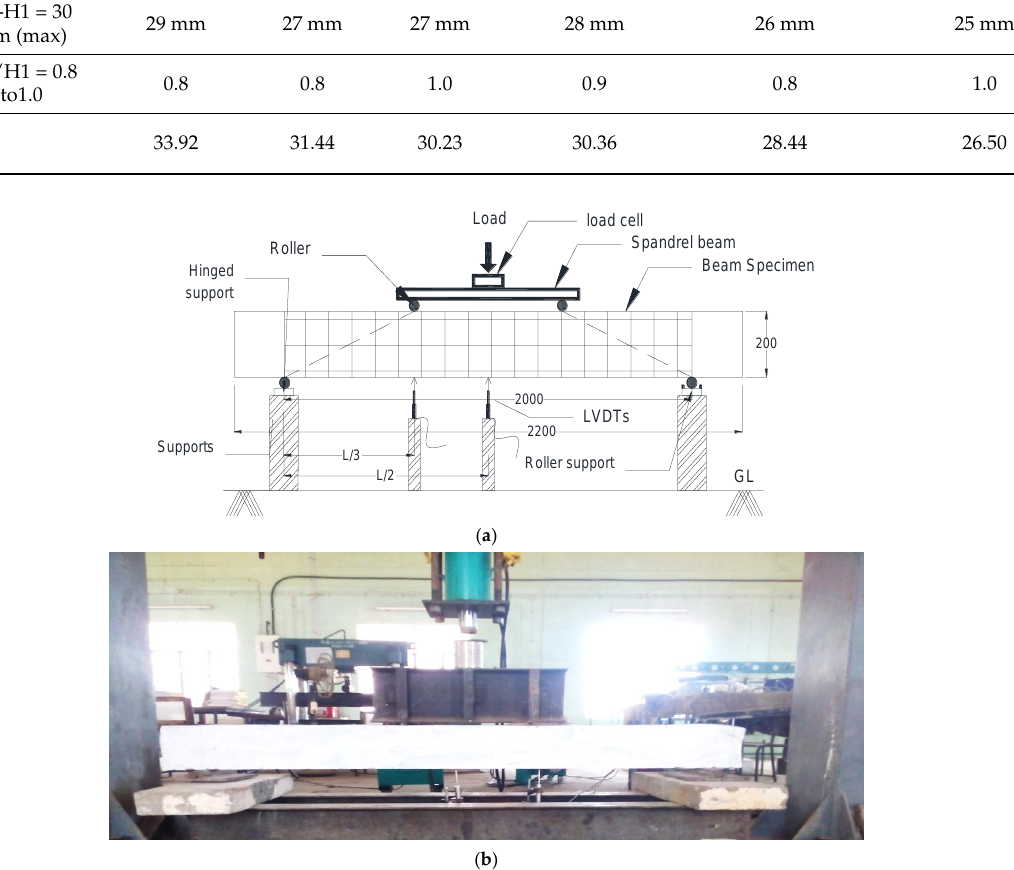
Figure 3. Details of the test setup test procedure. ( a ) Schematic diagram of the test setup (all di- mensions are in mm). ( b ) Photograph of the test setup.